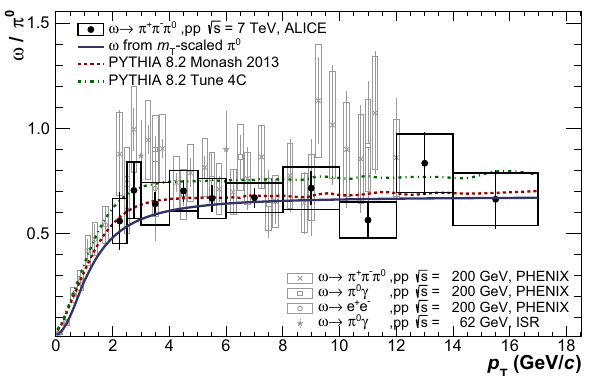
Fig. 5 Ratio of ω/π 0 production as a function of transverse momen- √ s = 7TeV (black) compared to various tum p T for pp collisions at √ s = 62 − 200GeV [15–18] lower collision energies ranging from √ s = 7TeV and the ω/π 0 (gray). In addition, PYTHIA predictions at ratio obtained from m T -scaling are shown with